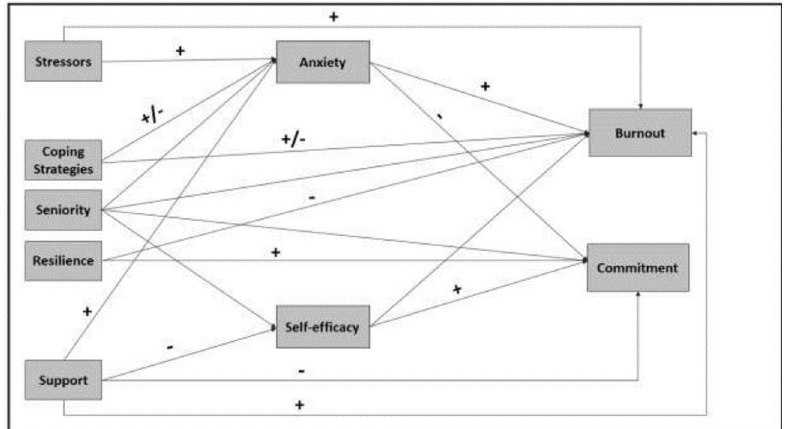
Fig 1. A suggested analytical model showing the hypothesized relationship between factors affecting teachers’ burnout and professional commitment during the pandemic. Hypothesized positive correlations are marked by ‘+’, negative correlations are marked by a ‘-’ sign, and connections which incorporate both positive and negative dimensions are marked by a ‘+/-’